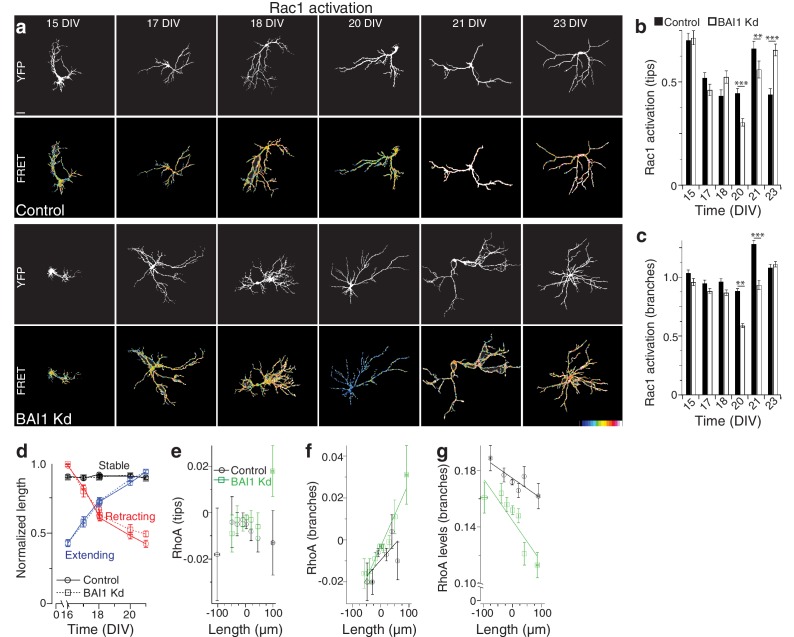
Effect of BAI1 Kd on dendritic Rac1 activation through development and lack of robust correlation of some RhoA parameters with dendrite growth.(a) Representative images of hippocampal neurons expressing RaichuEV-Rac1 alone (control) or with shRNAs against Adgrb1 (BAI1 Kd) measured at the indicated times. Overall dendrite structure was ascertained by directly exciting the FRET acceptor (YFP images), while relative Rac1 activation is shown in the FRET images according to the color code in the lower right corner (low values on the left, high on the right, see Methods). Note that population growth trajectories in the RaichuEV-Rac1 expressing were similar to those observed in Figure 2. Images are masked to remove axons and dendrites from other neurons. Bar is 20 µm. (b) Summary data for Rac1 activation at dendrite tips. Total number of neurons: 51 and 52 for control and BAI1 Kd at 15 DIV, 54 and 41 at 17 DIV, 53 and 47 at 18 DIV, 41 and 36 at 20 DIV, 47 and 34 at 21 DIV, and 52 and 46 at 23 DIV (N = 5). There were no differences in Rac1 activation in control vs. BAI1 Kd neurons at dendrite tips (panels a,b), dendrite branch points (panels a,c), or whole dendrites (data not shown) until 20 DIV, when arborization differences in BAI1 Kd were already readily apparent (Panels d-f, Figure 2). Moreover, Rac1 was lower in BAI1 Kd neurons than in control neurons at 20 and 21 DIV, which would be expected to stunt dendritic growth. Thus, BAI1 signaling to Rac1 does not explain the phenomena exhibited in Figures 1–2. The elevation of Rac1 activation at dendrite tips at 23 DIV does indicate that Rac1 overactivation may drive dendrite overgrowth in BAI1 Kd neurons at or after the time frame of normal dendrite growth arrest on which we concentrate in this study. (d) Relative length trajectories for stable, retracting, and extending dendrites in control (circles, solid lines) and BAI1 Kd (squares, dashed lines). Maximum length of individuals throughout the time course was assigned a value of 1.0 and all other values calculated relative to this. Note that while the proportion of extending and retracting dendrites is different in control vs. BAI1 Kd neurons (Figure 3d), the extent to which individual dendrites extend or retract relative to their maximum length is the same in control and BAI1 Kd neurons. Total number of neurons is the same as in Figure 3i. e through g Correlation of different RhoA activation parameters in dendrites with dendrite growth behavior. All of the individual events between days in the time course shown in Figure 3e–f were pooled and arrayed as shown. Unlike the robust negative correlation between RhoA activation at dendrite tips shown in Figure 3i, the following correlations were not informative. Panel (e) shows the relationship between the change in RhoA activation at dendrite tips between time points and the accompanying changes in dendrite length. These changes were relatively small on average and the apparently positive correlation in the BAI1 Kd neurons is due to an outlier on the right whose ordinate is not significantly different from those of the other points in the BAI1 Kd series. Panel (f) shows the relationship between the change in RhoA activation at dendritic branch points and accompanying changes in dendrite length in control an BAI1 Kd neurons. The ordinates in the control pool have no significant differences, indicating that there is no relationship between the two. There is a positive correlation between the changes in RhoA activation at dendritic branch points and dendrite growth, indicating that these changes in RhoA activation may drive dendrite behavior in BAI1 Kd neurons, though they do not in wild type neurons. Panel (g) shows the correlation between the levels of RhoA at dendritic branch points and dendrite growth. There is negative correlation between these parameters in control neurons, and an even more robust negative correlation in BAI1 Kd neurons. These data further support the notion that RhoA activation levels at branch points drives dendrite growth in BAI1 Kd neurons, and this relationship is more compelling than that in Panel E. Data are represented ± s.e.m. (***p<0.0001, **p<0.01, *p<0.05) Detailed statistics are found in Figure 3—figure supplement 2—source data 1.10.7554/eLife.47566.021Figure 3—figure supplement 2—source data 1.Statistical summary for Figure 3—figure supplement 2: ANOVA and key Tukey post-hoc tests and N and n values for Figure 3—figure supplement 2b,c.